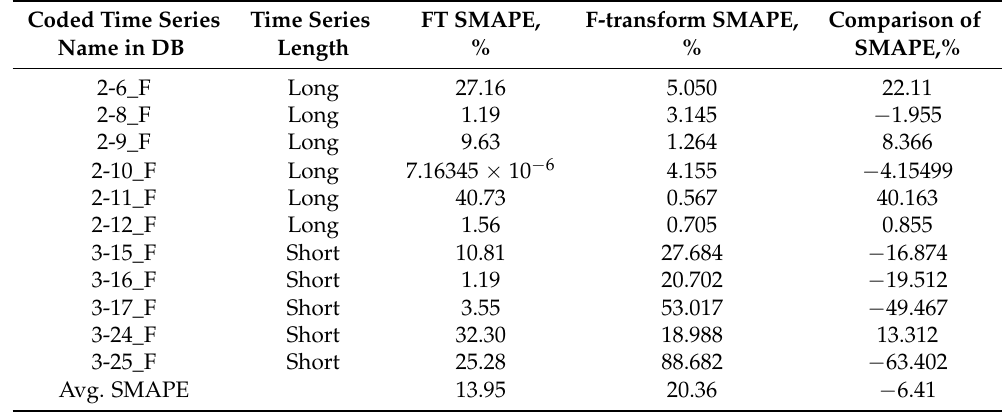
Table 7. First forecast quality comparison.